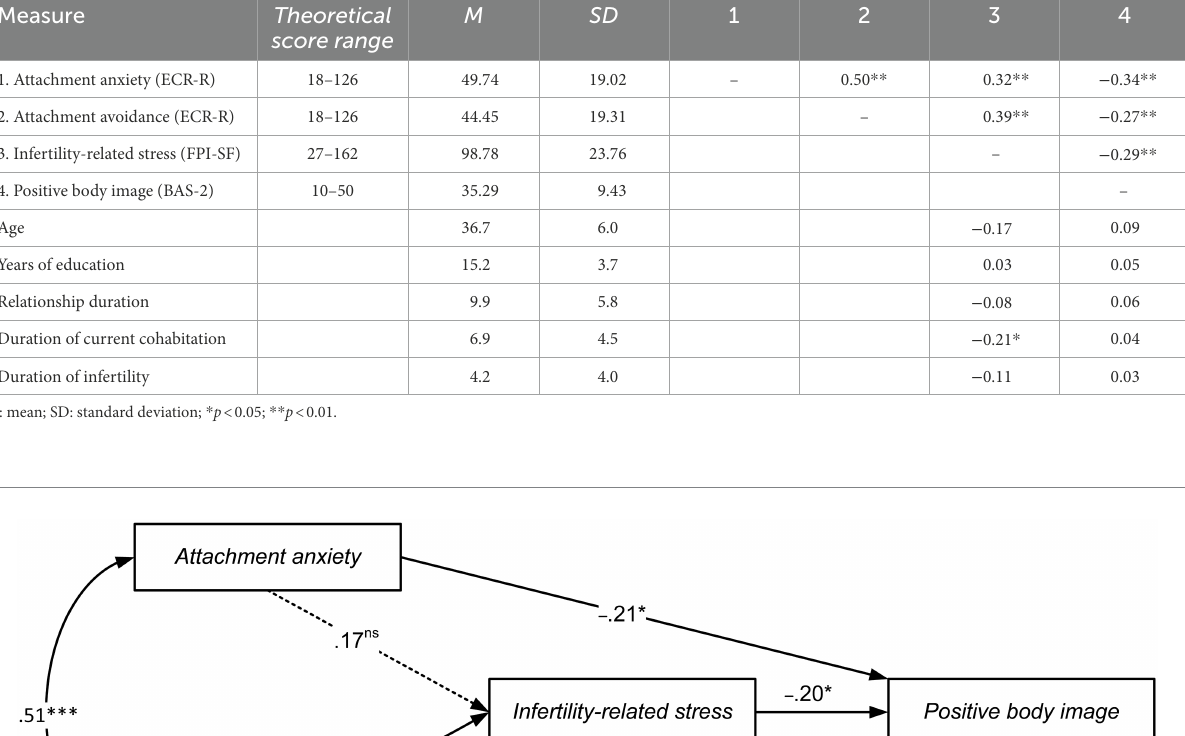
TABLE 1 Descriptive statistics and Pearson’s correlations among study measures and potential confounders.